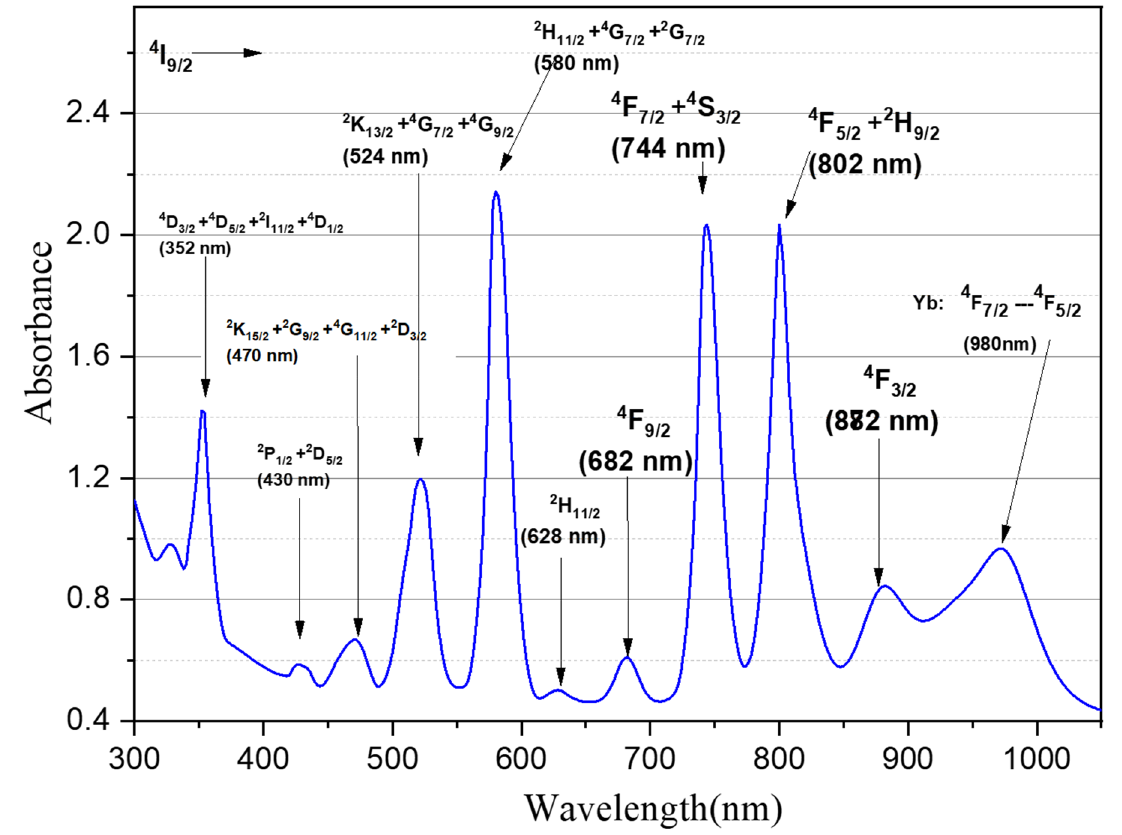
Figure 2. Absorption spectra of PZLBNdYb glass. The upper transition state is identified for each peak.